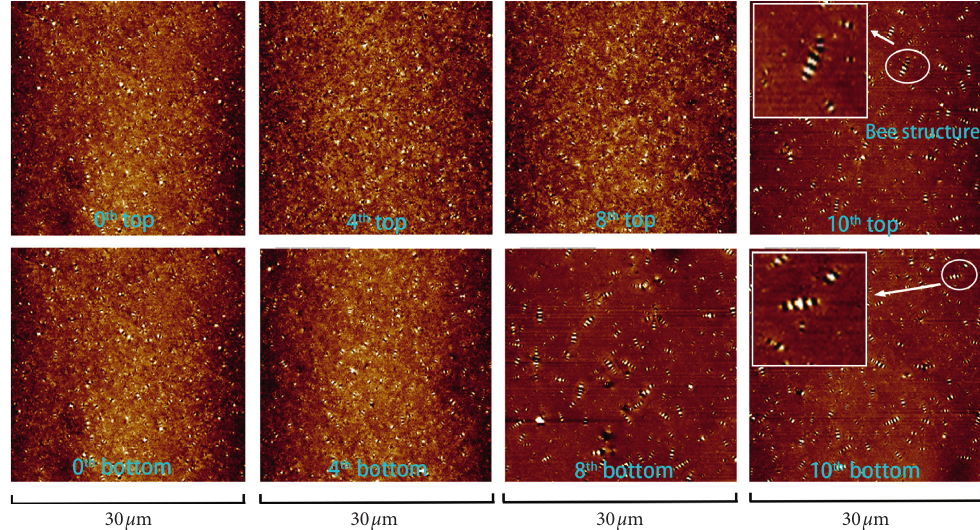
Figure 16: Phase diagram of SBS+ CNTs-I with increasing storage